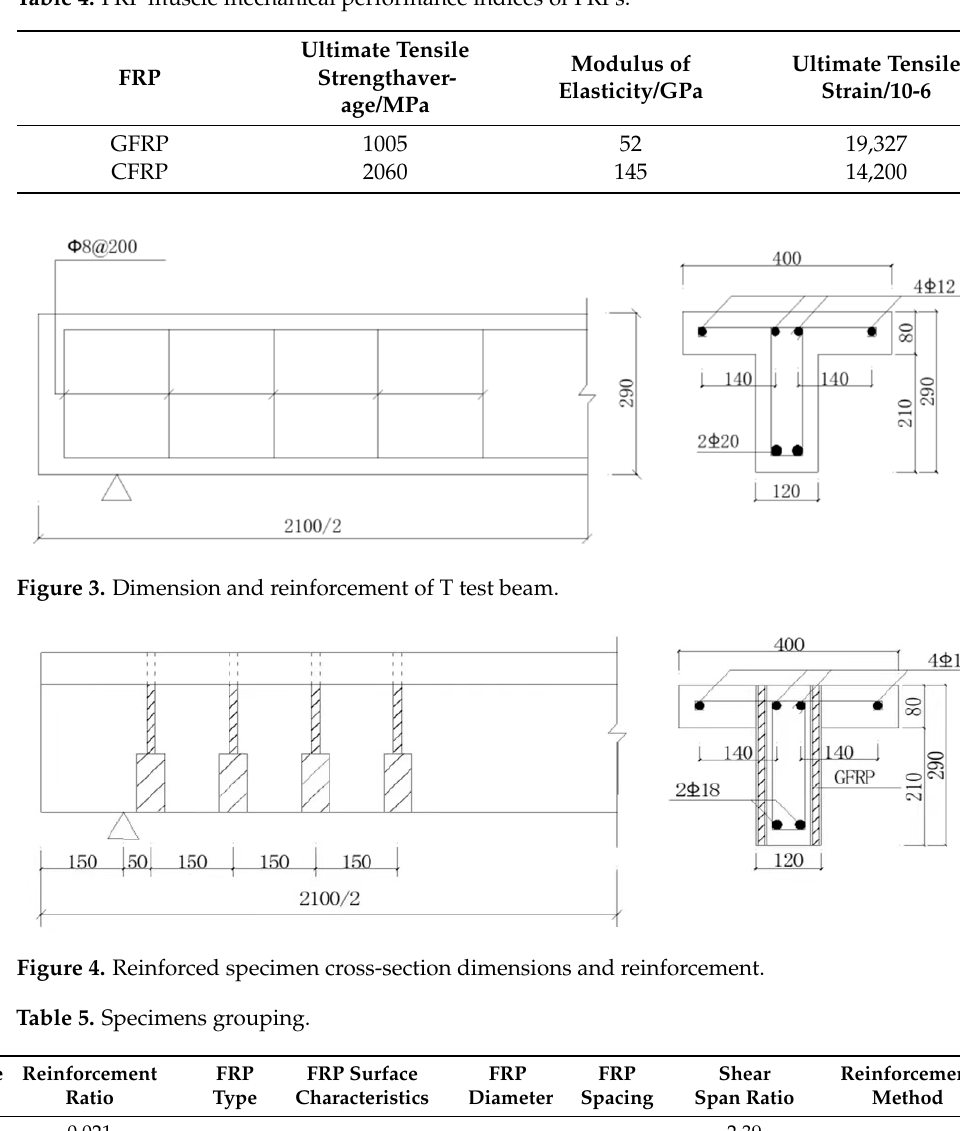
Table 4. FRP muscle mechanical performance indices of FRPs.